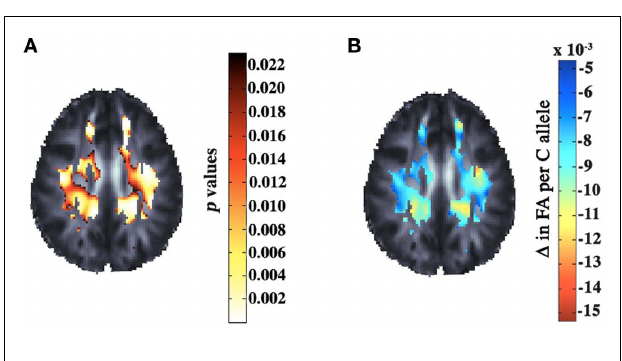
FIGURE 2 | Corrected p -values (A) and regression coefficients (B) are shown for the voxelwise effects of a candidate polymorphism in the CLU gene – a highly prevalentAlzheimer’s susceptibility gene – on fractional anisotropy maps derived from DTI scans of 398 young adults. The axial slice shows the extensive influence of the genetic variant on white matter structure. Adapted from Braskie et al.